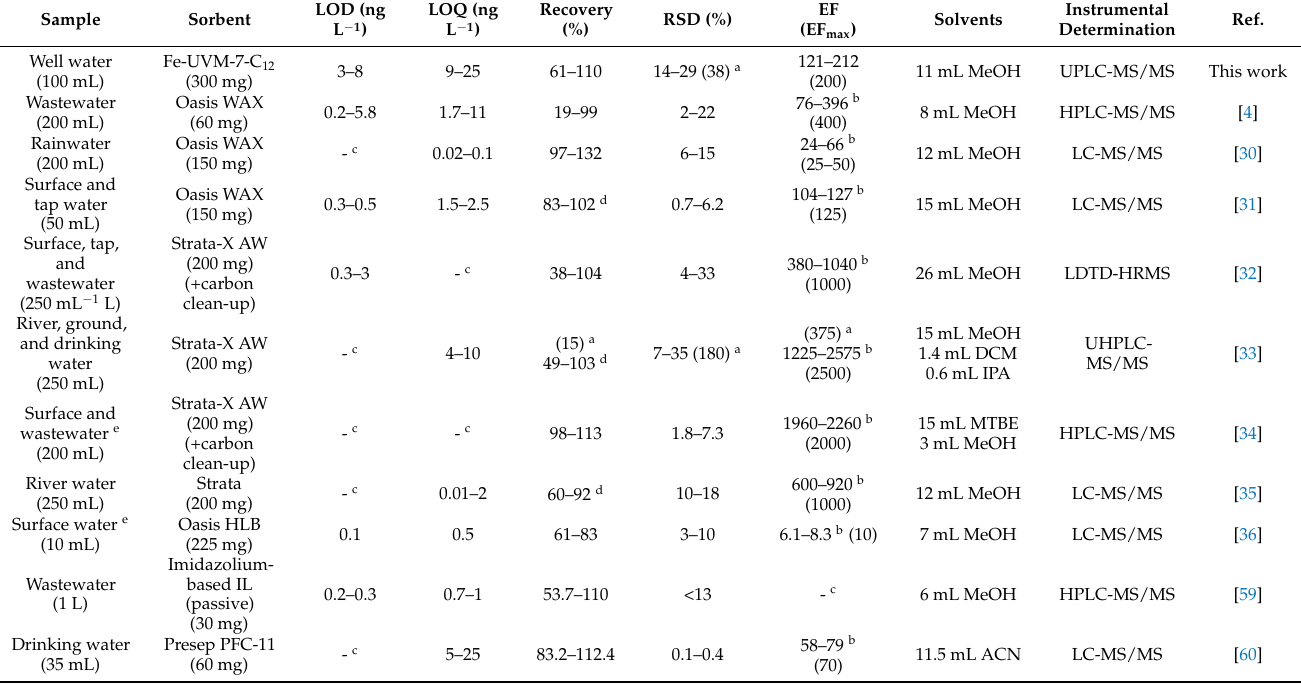
Table 3. Comparison of the proposed method with other reported SPE methods from the literature for the extraction of C 8 –C 14 PFASs from water